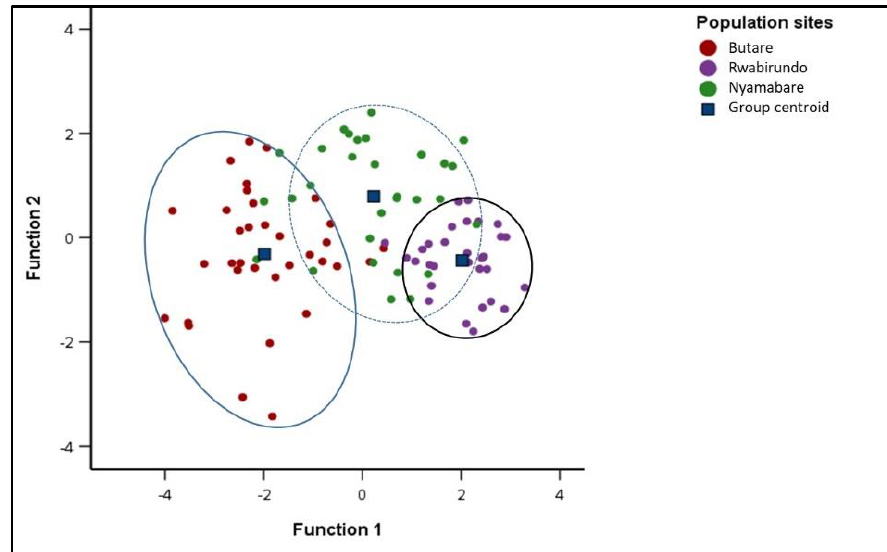
Figure 6. Canonical Discriminant Functions for the sub populations of Kabale. The population of Kayumbu in Kyanamira farm was very distinct and highly isolated Table 5. Classification Results for Kabale sub populations. from populations of Victoria and Kyoga. Additionally, more than 60% of the populations of Kyoga and Victoria were also distinct. Some samples were shared among the populations (Figure 7). The overall random assignment of individuals into their original group was high (81.1%) (Table 6). The proportion of individuals correctly classified into their original group, i.e., Victoria, Kayumbu, and Kyoga was 80.0%, 81.3%, and 81.8%, respectively (Table 6).